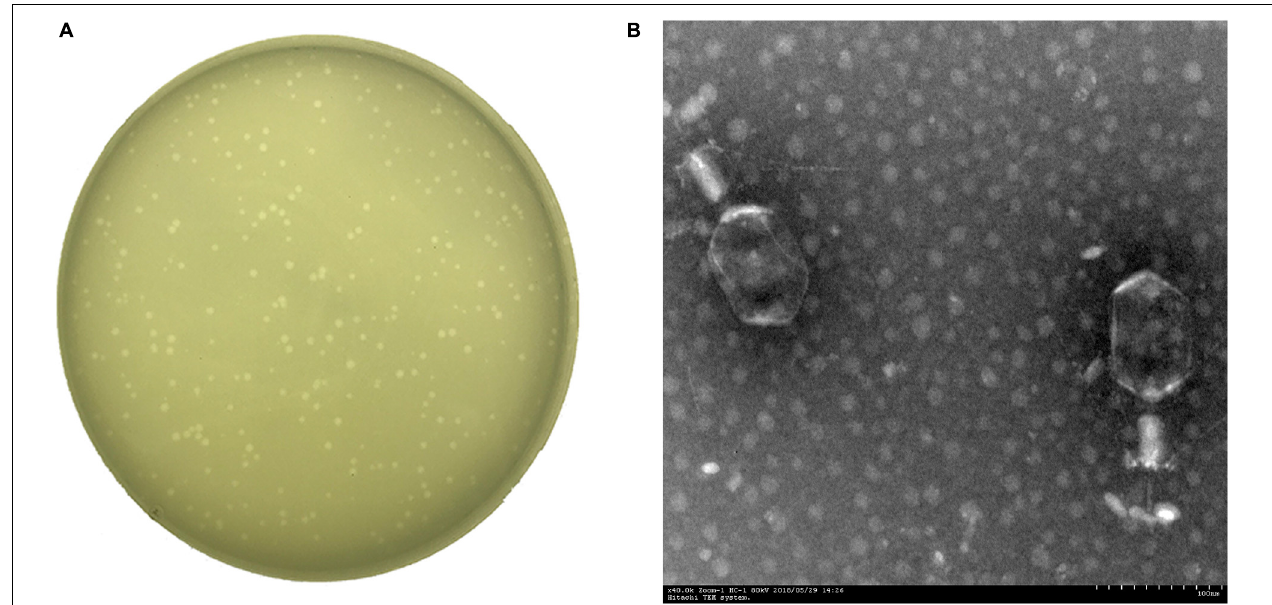
FIGURE 1 | The morphology of phage P-KP2. (A) The plaques formed by phage P-KP2 on the lawns of K. pneumoniae W-KP2. (B) The morphology of phage P-KP2 was determined by transmission electron microscopy (TEM). The scale bars represent 100 nm.